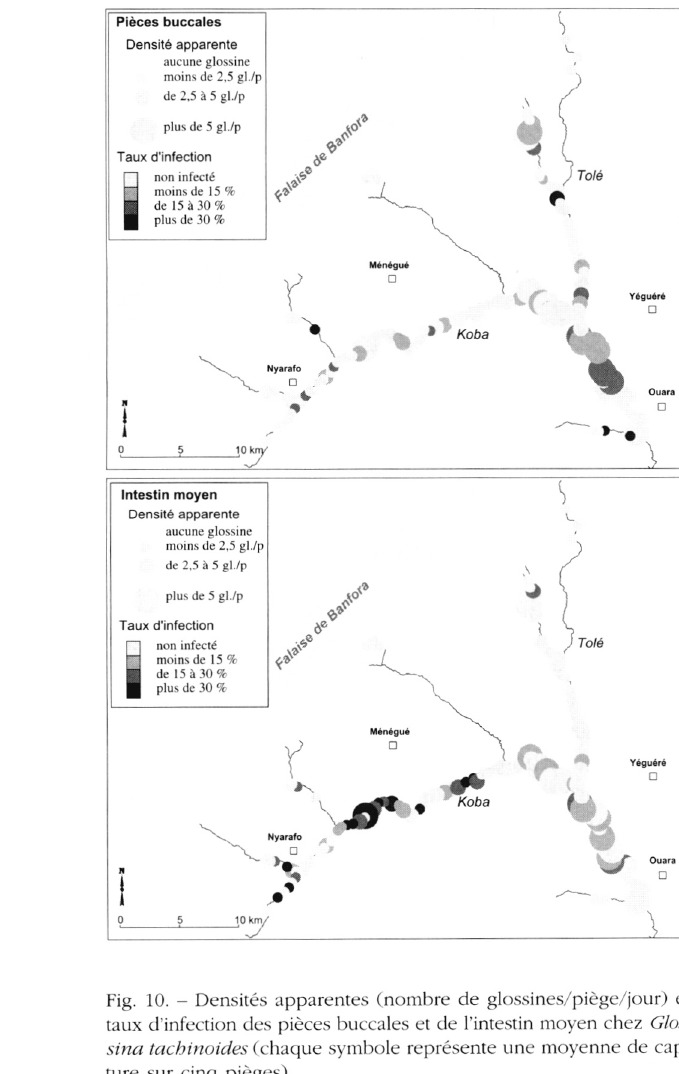
Fig. 10. - Densités apparentes (nombre de glossines/piège/jour) et taux d’infection des pièces buccales et de l’intestin moyen chez Glos- sina tachinoides (chaque symbole représente une moyenne de cap­ ture sur cinq pièges).